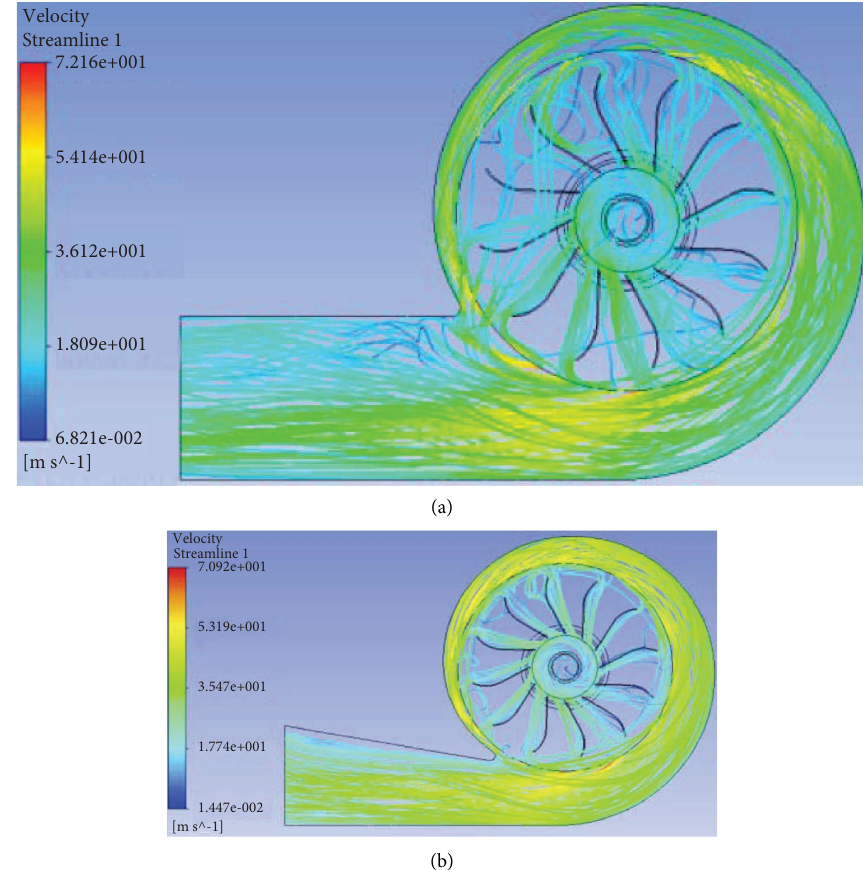
Figure 14: Velocity streamlines distribution: (a) before optimization and (b) after